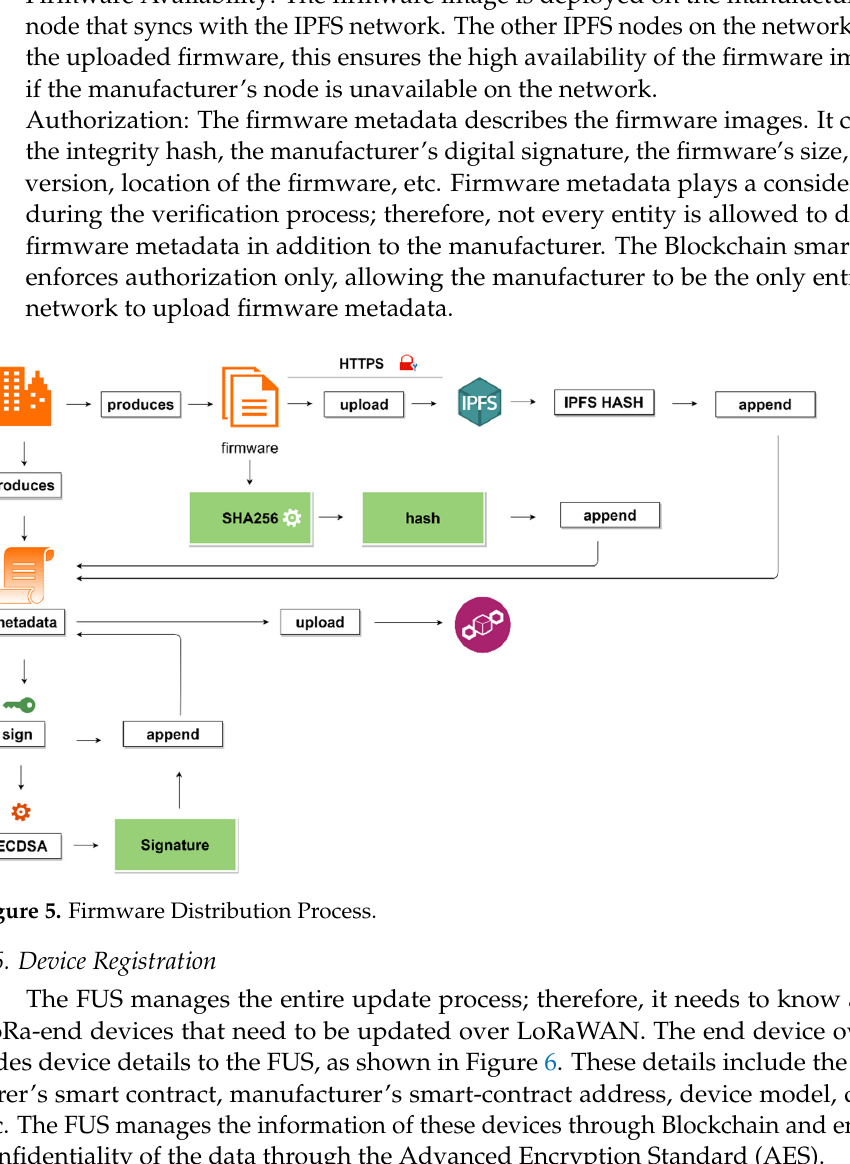
Figure 5. Firmware Distribution Process.